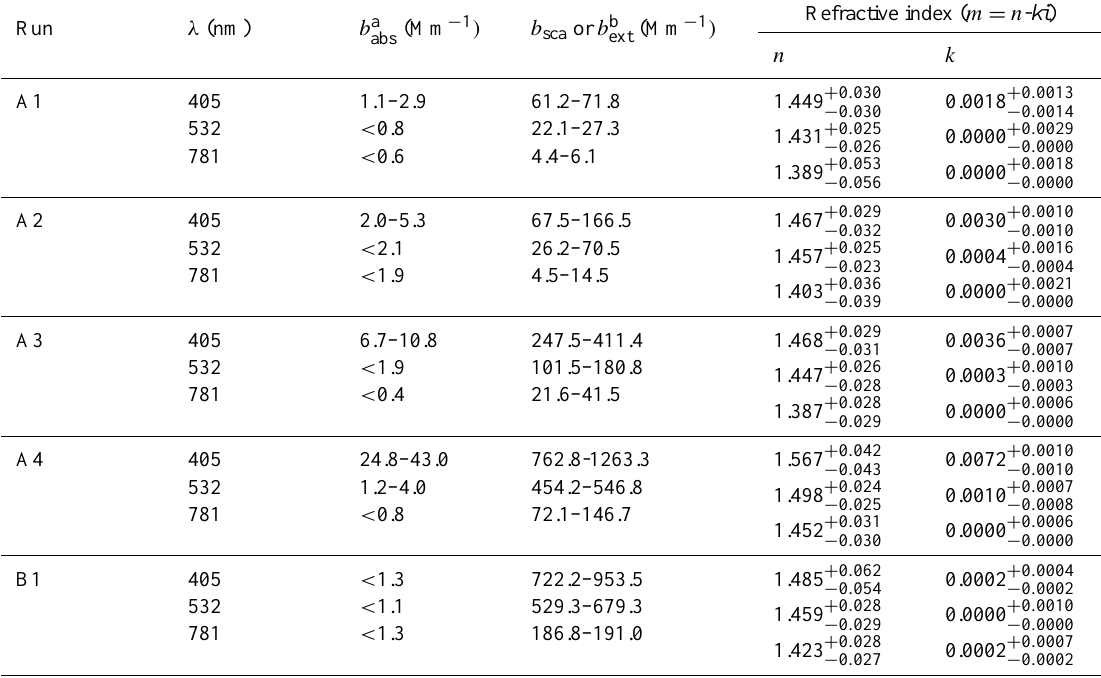
Table 2. Absorption, scattering, and extinction coefficients used for the analyses and the RI-values determined in the present study.